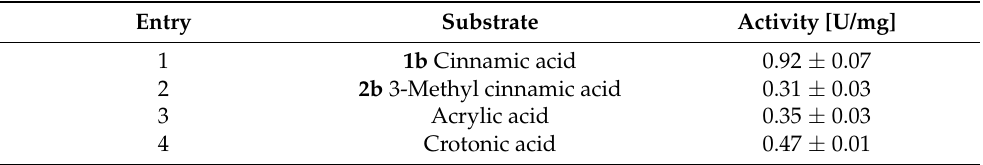
Table 2. In vitro activity of Nc CAR measured by NADPH depletion. The assay was not conducted with all compounds due to absorption ( 3b , 4b ) and solubility ( 5b – 8b )